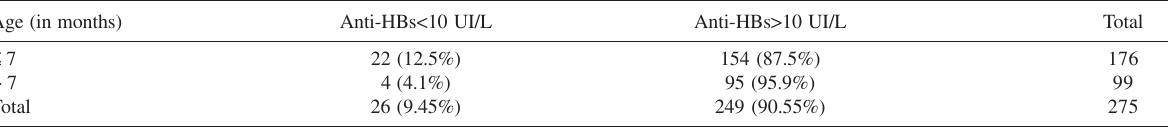
Table 1 - Mothers’ serostatus versus children’s seroconversion Age (in months)